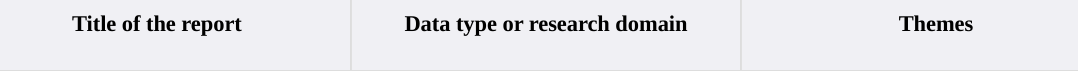
Table 3. The list of 19 projects included in the online reproducibility resource collection and their